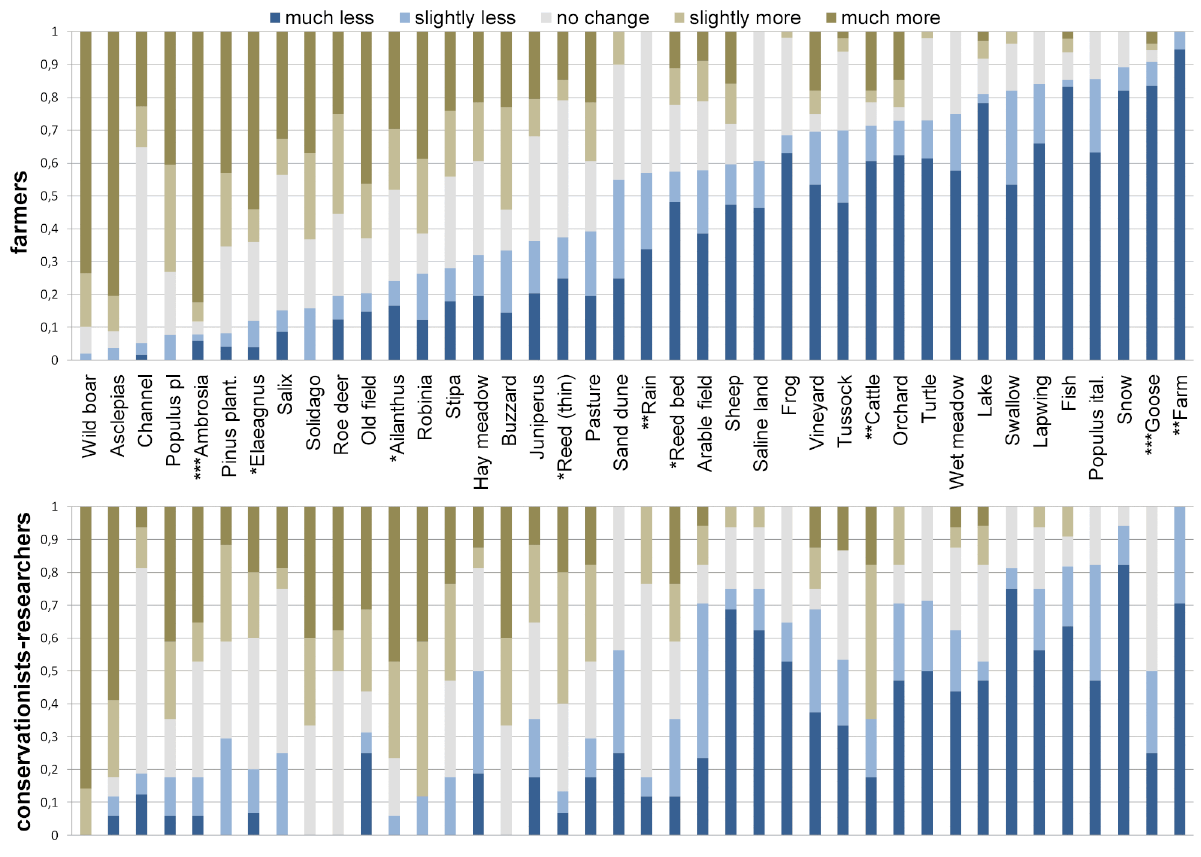
Fig. 1 . Perceived trends of landscape elements by farmers and conservationists-researchers (Mann-Whitney test, * < 0.05; ** < 0.01; *** <